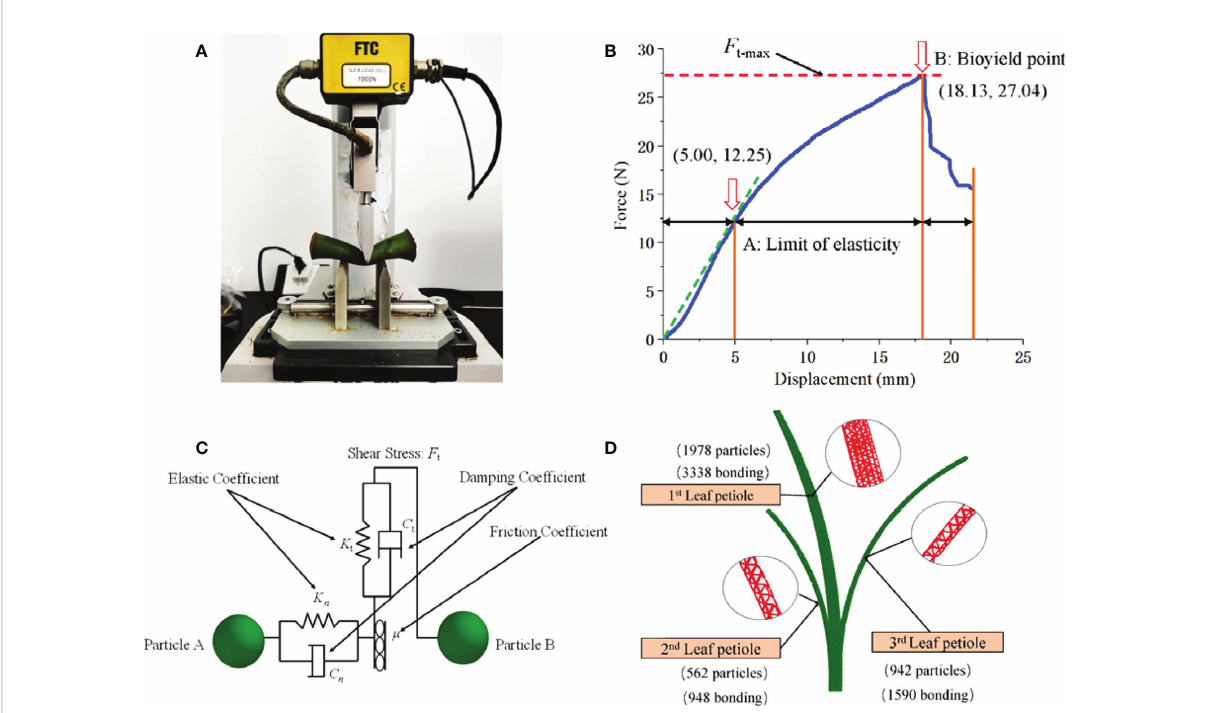
FIGURE 3 Discrete element model of petiole. (A) Three point bending experiment of petiole; (B) Displacement-Force of petiole obtained by three-point bending test; (C) Discrete element model and particle number of petiole; (D) Inter-particle force of